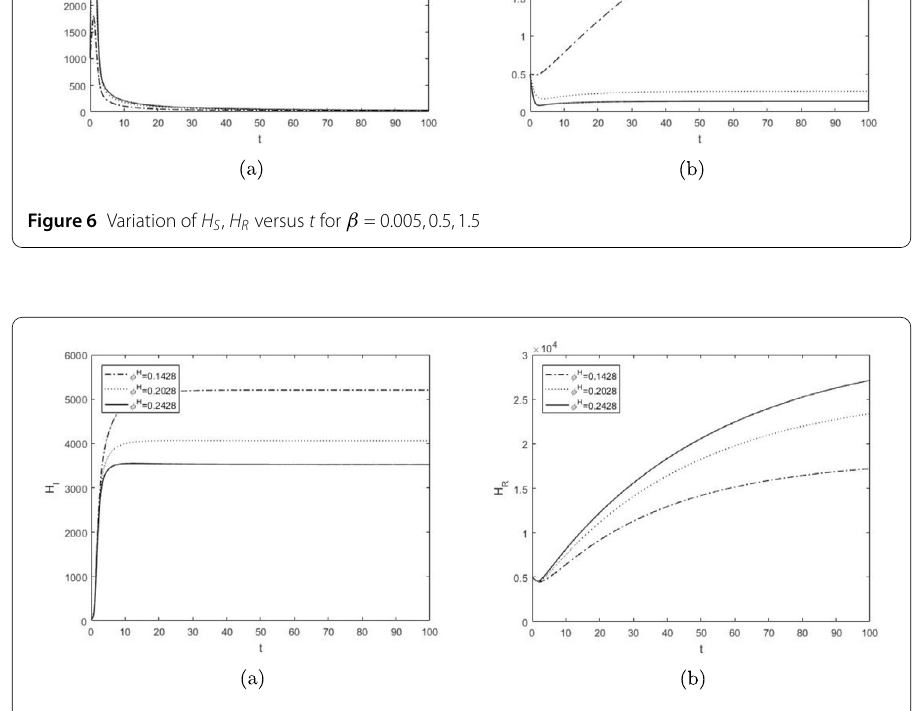
Figure 7 Variation of H I , H R versus t for φ H =